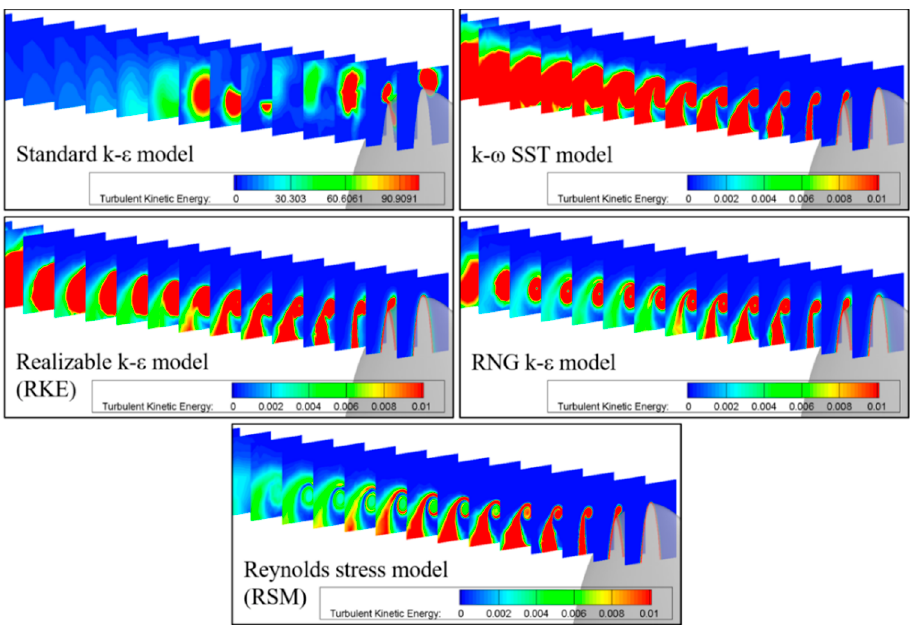
Figure 12. Comparison of turbulent kinetic energy in tip-vortex for different turbulence models.